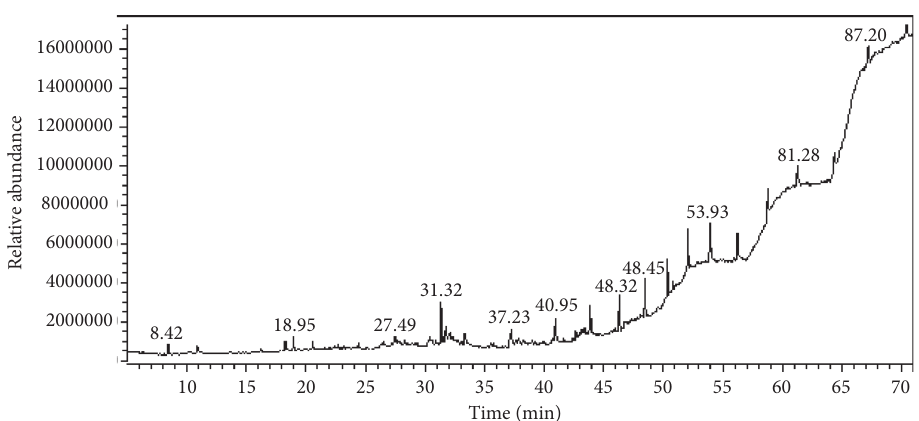
Figure 2: Total ion GC-MS chromatogram of the petroleum ether extract of S. persica